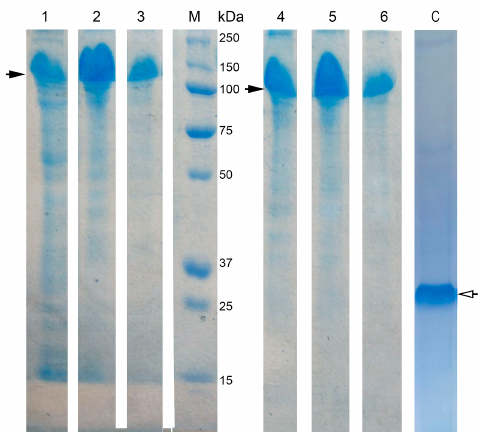
Figure 2. SDS-PAGE of the soluble recombinant protein fractions after expression and purification. 1—crude soluble cell extract fraction after the expression of 40HSP70/EIII plasmid; 2 and 3—purified hybrid HSP70/EIII 40 µg and 20 µg per lane, respectively; M—molecular weight marker of proteins (Bio-Rad); 4—crude soluble cell extract fraction after expression of 40HSP70 plasmid; 5 and 6— purified recombinant HSP70 (40 µg and 20 µg per lane, respectively); C—purified control protein DsbC. Empty arrow—control band (DsbC-overhang, lane C); filled arrows—bands of the recombinant HSP70/EIII and HSP70 (lanes 1–6).